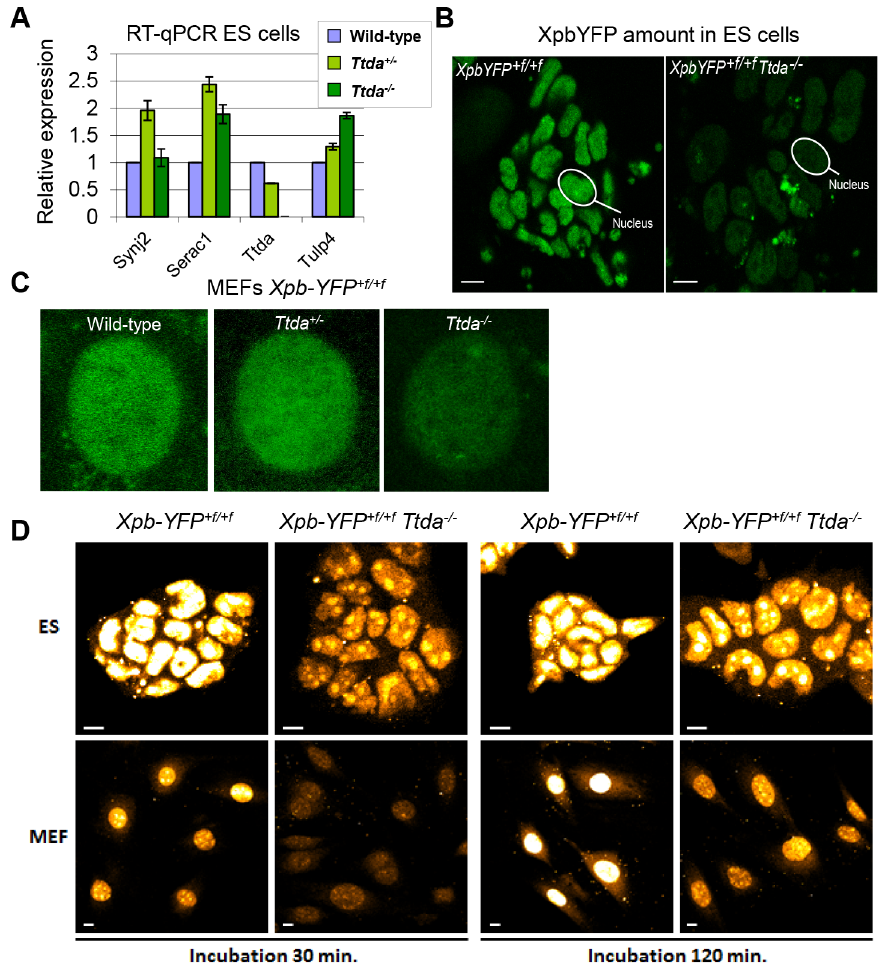
Figure 6. Gene expression levels and TFIIH amount in Ttda 2 / 2 ES cells. (A) Relative expression levels of mRNAs neighboring genes encoding Synaptojamin 2 ( Synj2 ), Serine active site containing 1 ( Serac1 ), Trichothiodystrophy group A ( Ttda ) and Tubby like protein 4 ( Tulp4 ) in Ttda 2 / 2 (n=2), Ttda + / 2 (n=2) and wild-type (n=2) ES cells as determined by quantitative RT-PCR. The levels were normalized to Gapdh and the error bars indicate SEM between experiments. (B) Representative confocal microscope pictures of XpbYFP + f/ + f Ttda 2 / 2 , XpbYFP + f/ + f Ttda + / 2 and XpbYFP + f/ + f MEFs isolated from 10.5-day-old embryos. (C) Confocal images of ES cells isolated from XpbYFP + f/ + f mouse model (left panel) and from XpbYFP + f/ + f Ttda 2 / 2 mouse (right panel). The green signal is the direct fluorescence of the YFP tagged protein. The white bar measures 10 mm. (D) Confocal images of EU incorporation into ES cells isolated from XpbYFP + f/ + f mouse model and from XpbYFP + f/ + f Ttda 2 / 2 mouse (upper panel) and MEF’s isolated from the same mouse models (lower panel). Two EU incubation times have been performed: 30 minutes (left panels) and 120 minutes (right panels). The white bar measures 10 mm.